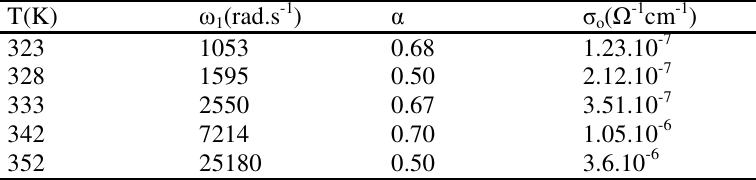
Table 4. Least squares fit parameters of the imaginary part of permittivity ( ε